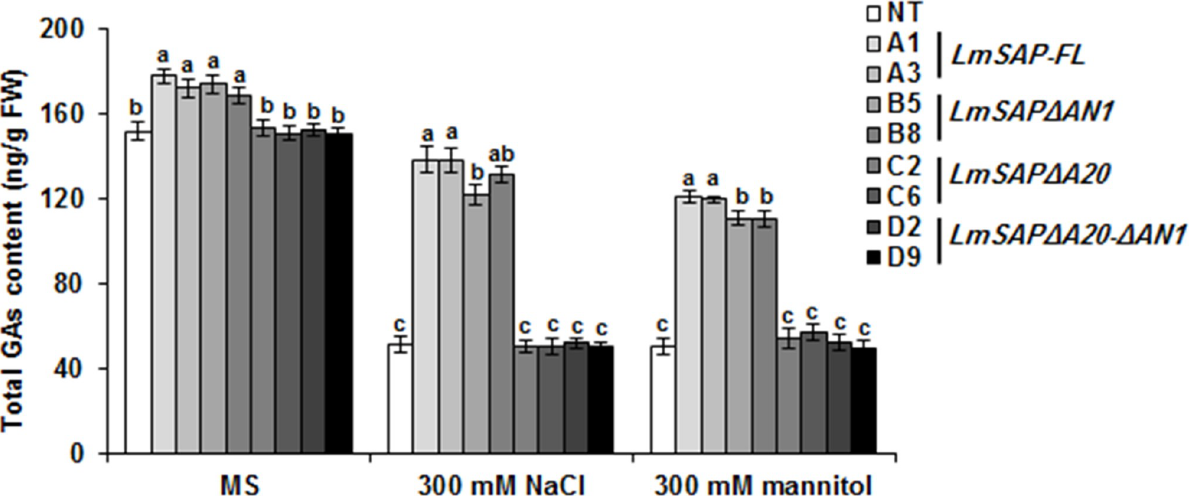
Fig 4. Endogenous GAs content quantified using HPLC in LmSAP -overexpressing lines and non-transgenic (NT) plants grown on MS medium (control), MS medium supplemented with 300 mM NaCl , and MS medium supplemented with 300 mM mannitol. Data represent the means ± SEM of three biological replicates. Means denoted by the same letter did not differ significantly at p < 0.05.